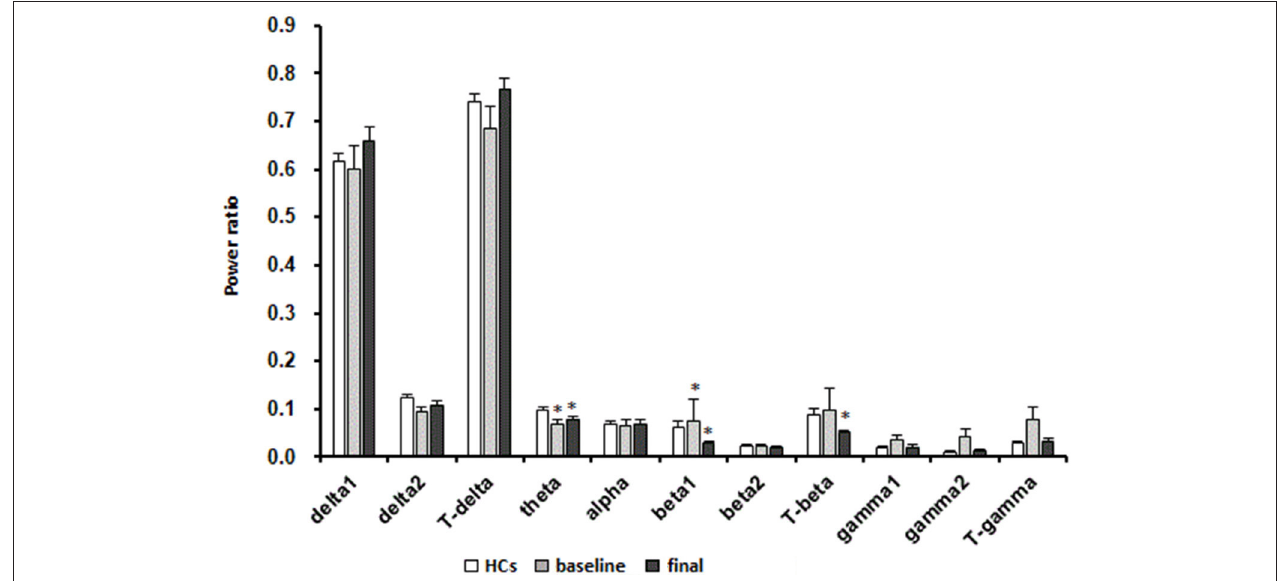
FIGURE 4 | Effects of escitalopram on sleep power measures. The data are expressed as mean ± SE. n = 13 MDD patients. n = 13 healthy controls. * p < 0.05, different from healthy controls; HCs, healthy controls; Baseline, MDD patients before treatment; Final, MDD patients at the end of 8 weeks of escitalopram treatment.